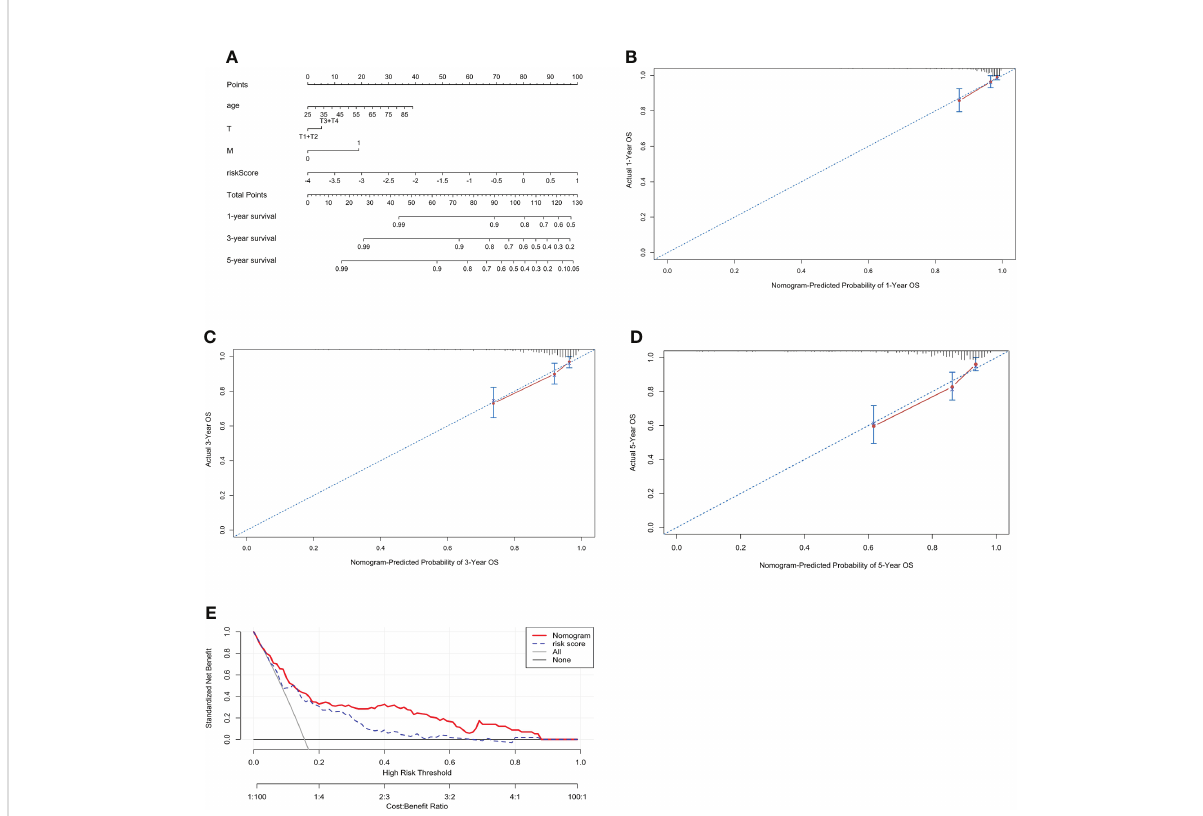
FIGURE 5 Construction of a prognostic nomogram including the risk score for ccRCC. (A) A nomogram for predicting the 1-, 3- and 5-year overall survival of individual ccRCC patients. The calibration curve for predicting the 1-year (B) , 3-year (C) , and 5-year (D) overall survival of ccRCC patients. The better the red line and the 45° dashed line fi t, the better uniformity between the nomogram-predicted and actual probabilities. (E) DCA curves of the nomogram and risk